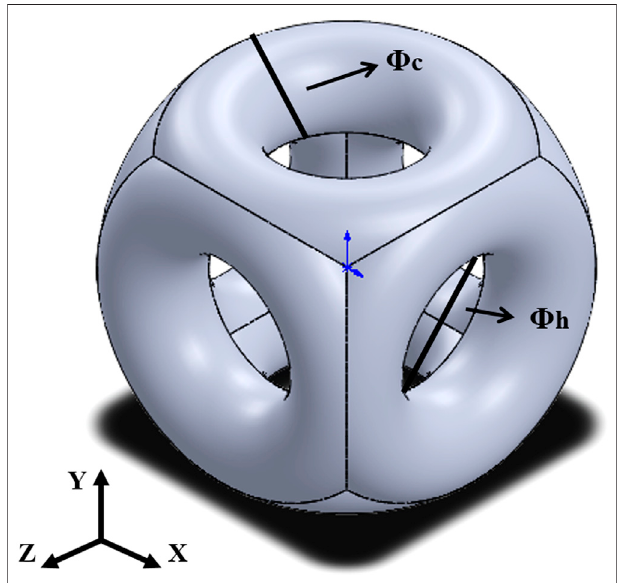
FIGURE 16 | Geometric model of the RS porous structure.